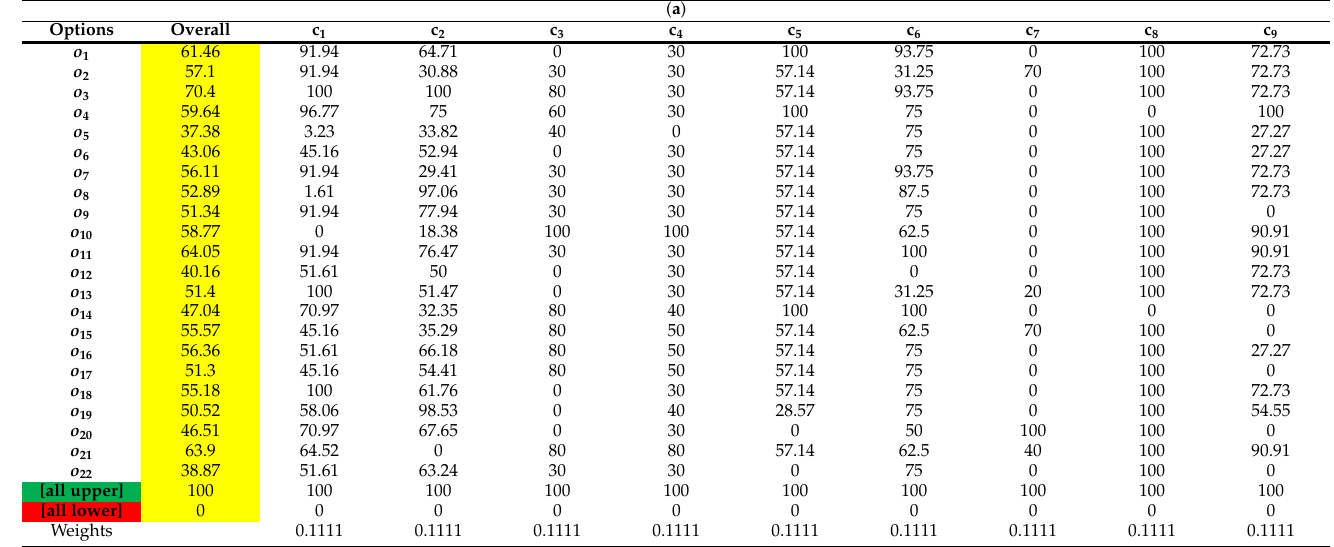
Table A2. ( a ) Second scenario—the scores of pairwise comparisons of offers. ( b ) Second scenario— rankings of offers per